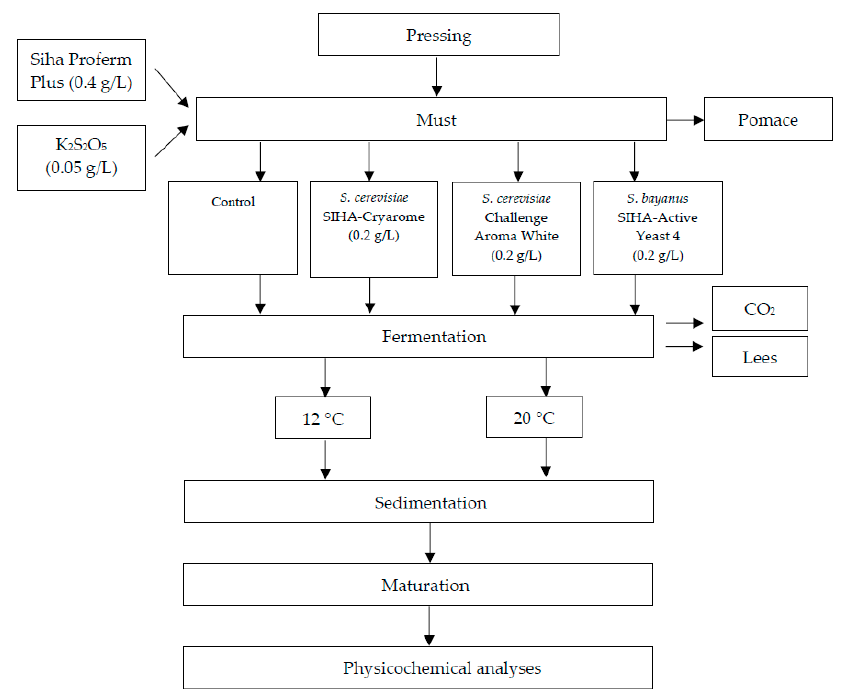
Figure 1. Scheme of the production of Aurore cv. white wine.